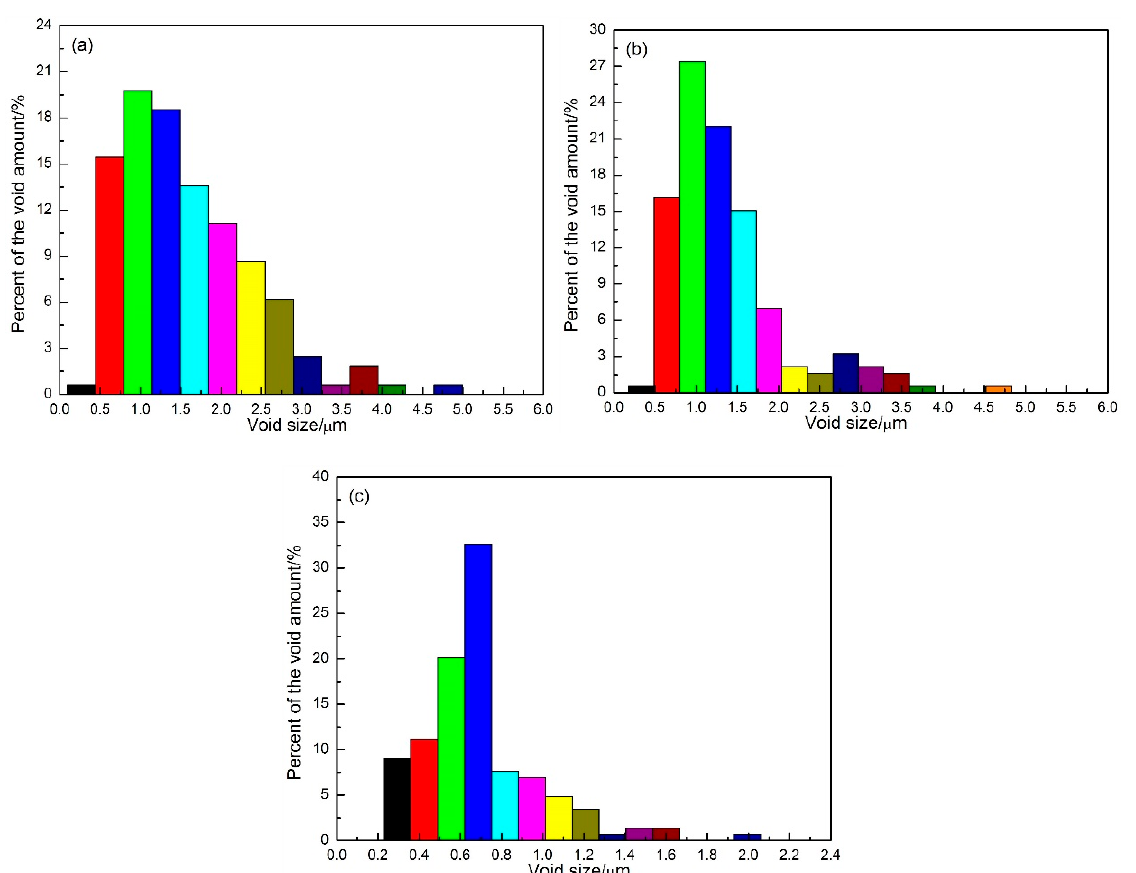
Figure 7. Void size in the bonding interface at different times: ( a ) 1 min; ( b ) 3 min; ( c ) 5 min.